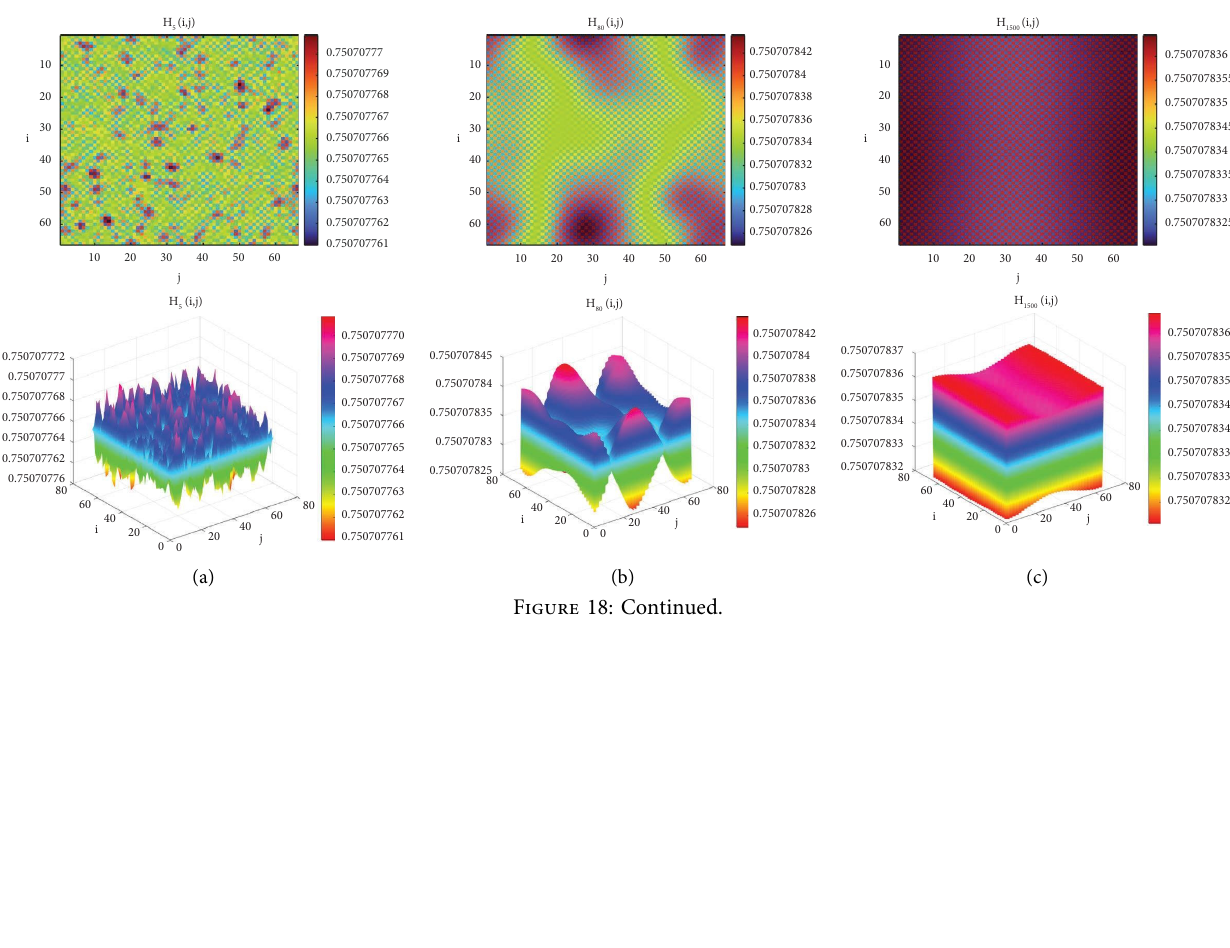
Figure 17: R � 2 , k � 1, c � 0 . 8, σ ∗ � 0 . 278655, σ � 0 . 5, ( d which is consistent with the case of Corollary 3(4), a Neimark-Sacker bifurcation occurs, parasite and host populations exhibit periodic